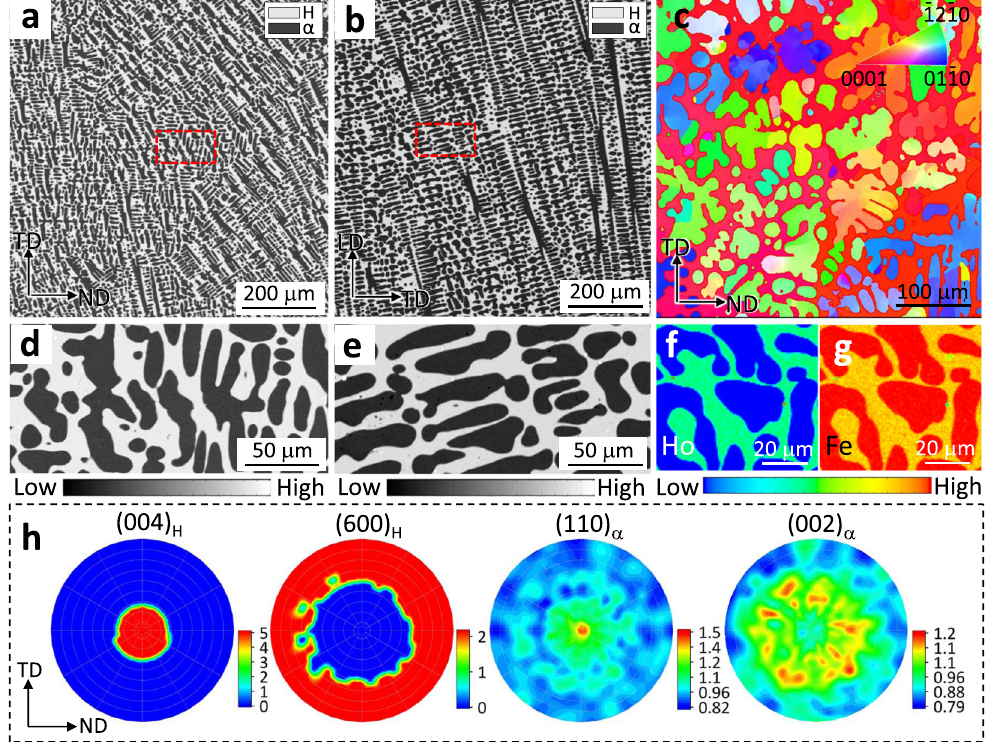
Fig. 2 Microstructures of the ZTE alloy. a – b , d – e The morphology of the as-cast S-4 alloy con fi rmed by electro-probe microanalyzer (EPMA) in TD (transverse direction)-ND (normal direction) plane ( a ) and LD (loading direction)-TD plane ( b ), respectively. ( d ) and ( e ) are enlarged regions in ( a ) and ( b ) marked with a red box. c Electron back-scattered diffraction (EBSD) inverse pole fi gure of crystal orientation for S-4 inside the TD-ND plane. f – g Element mappings of Ho ( f ) and Fe ( g ). h Pole fi gures by neutron diffraction texture analysis for the bulk orientations of (004) H , (600) H , (110) α , and (002) α